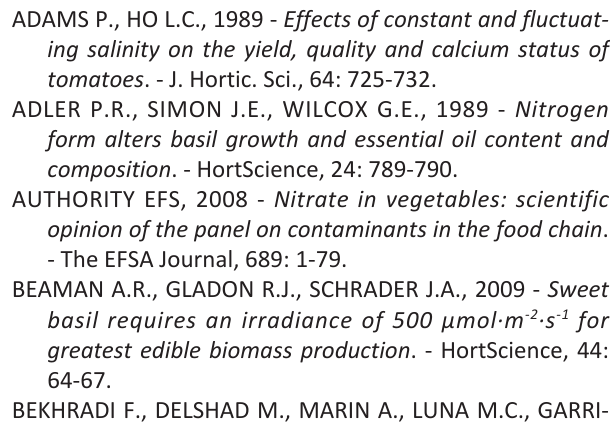
No. plants per pot